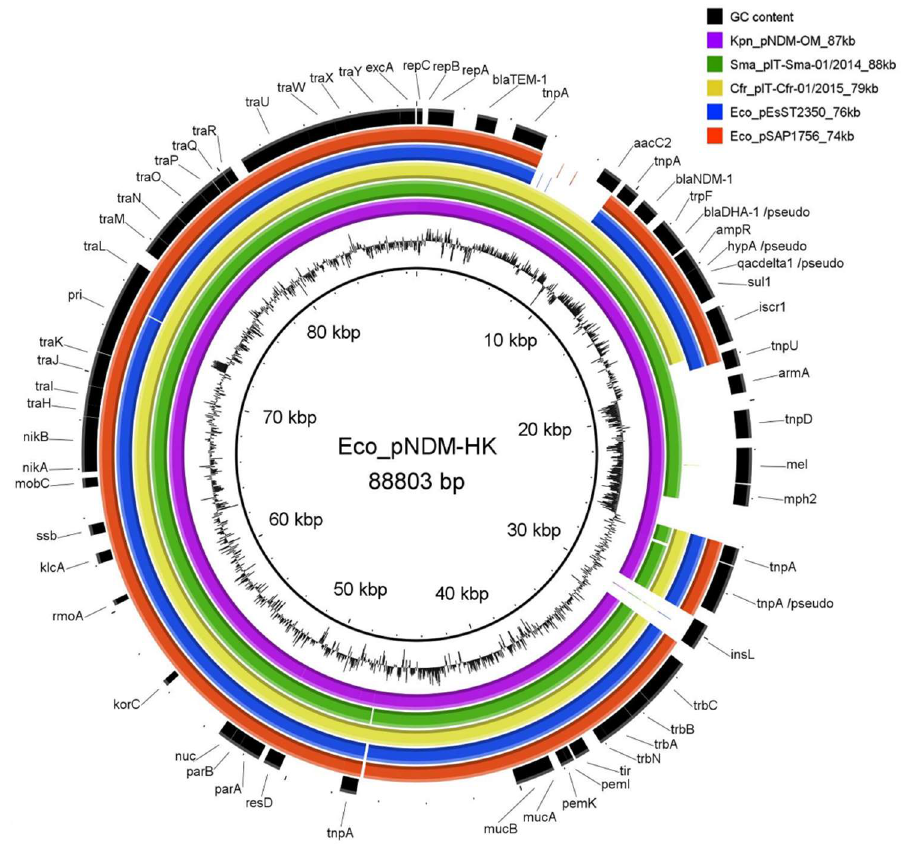
Figure 1. Comparison of closely related IncL/M plasmids, aligned against the reference plasmid pNDM- HK, using BLAST Ring Image Generator (BRIG) [17]. Genbank accession numbers, bacterial hosts, plasmid sizes and ring characteristics: pNDM-HK (HQ451074, E. coli , 88,803 bp, innermost ring, reference), pNDM-OM (JX988621, Klebsiella pneumoniae , 87,185 bp, purple ring), pIT-Sma-01/2014 (MH722219, Serratia marcescens , 88,129 bp, green ring), pIT-Cfr-01/2015 (MH722216, Citrobacter freundii , 78,923 bp, yellow ring), pEsST2350_SE_NDM (CP031322, E. coli , 75,645 bp, blue ring) and pSAP1756 (( E. coli , 73,743 bp, red ring). The outermost ring shows the genes identified in the reference plasmid pNDM-HK and the diagram next to the innermost ring represents the GC content of the reference plasmid.